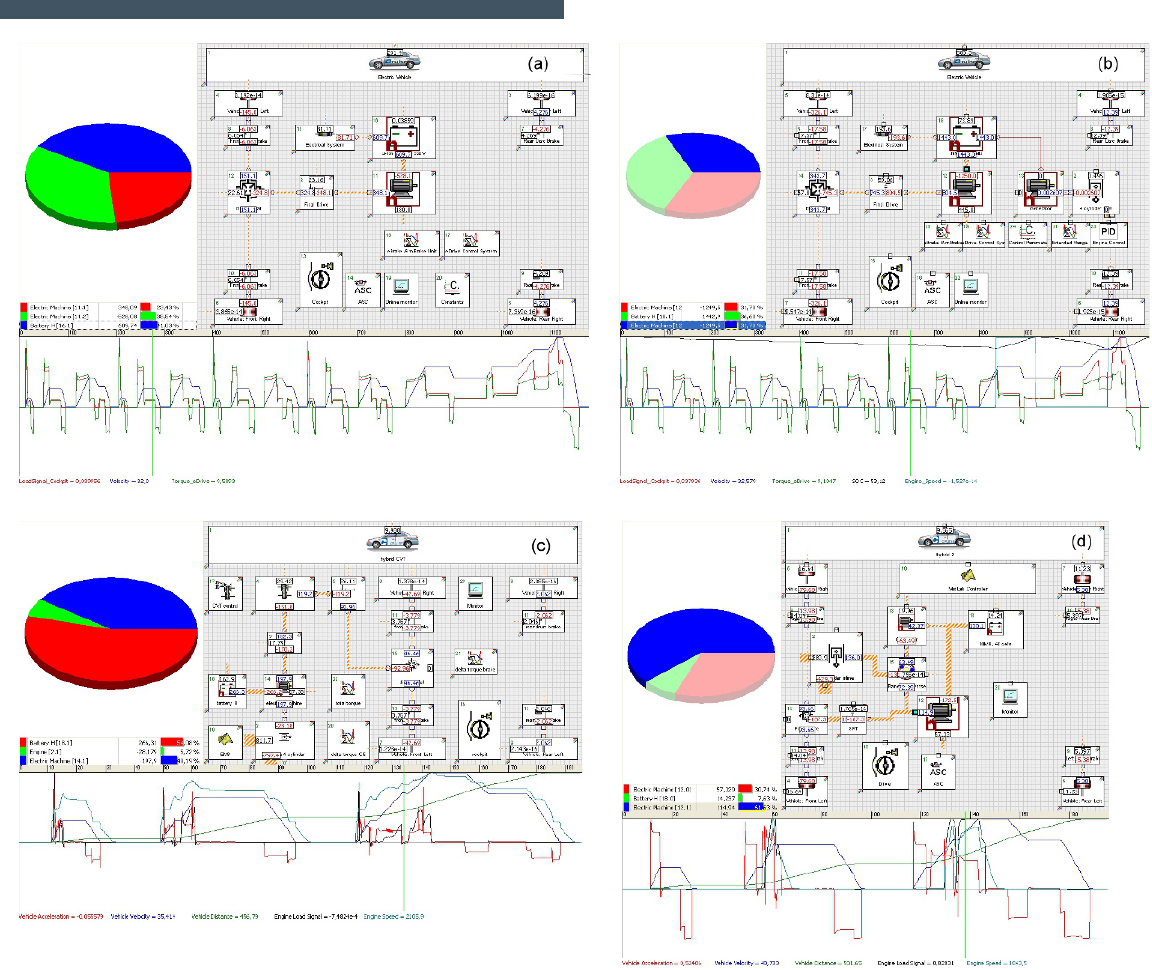
Figure 9. The energy flow graphics in respect of: Electric vehicle (a), Electric vehicle with range extender (b), Hybrid vehicle with CVT (c), Hybrid vehicle with planetary gearbox (d).